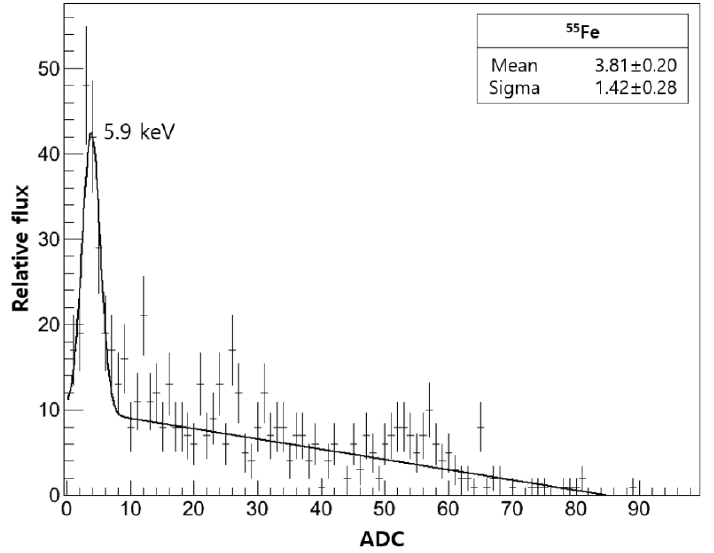
Figure 6. Energy measurements with 55 Fe X-ray source. 55 Fe has a peak at 5.9 keV. The solid line represents the fit of the Gaussian plus the straight line.